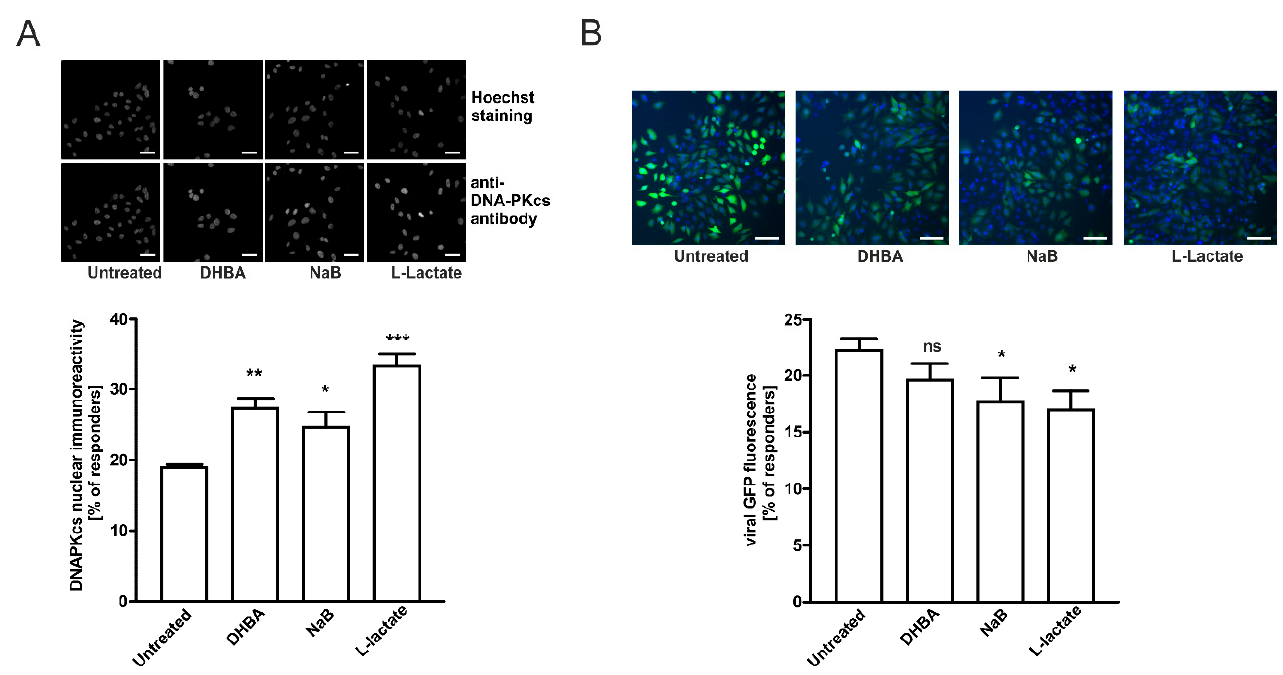
Figure 5. HCA1 and HDAC activity is required for lactate-mediated enhancement of DNA-PKcs nuclear localization and accounts for inhibition of lentiviral transduction in HeLa cells. ( A ) HeLa cells were treated with 250 µM DHBA, 0.5 mM sodium butyrate or 20 mM L-lactate for 24 h before measuring cellular DNA-PKcs immunoreactivity. The graphs display the percentage of high DNA-PKcs immunoreactive cells (responders) whose fluorescence overcame the threshold of mean fluorescence set on untreated cells. Data are presented as mean ± SD (n = 3) ( B ) HeLa were incubated in the presence or absence of 250 µM DHBA, 0.5 mM sodium butyrate, or 20 mM L-lactate, followed by infection with copGFP Control Lentiviral Particles at MOI = 5 for 24 h before changing the medium. After 48 h, infected cells were stained with Hoechst 33342 and immediately analyzed using an ArrayScan VTI HCS Reader. The graphs show the percentage of high copGFP expressing HeLa cells (responders) whose fluorescence overcame the threshold of mean fluorescence set on untreated cells. Data are presented as mean ± SD (n = 3). Images showed representative microscopic areas for the particular treatment from the same experiment. The scale bar is 50 µm. * p < 0.05, ** p < 0.01 and *** p < 0.001; not significant, ns.